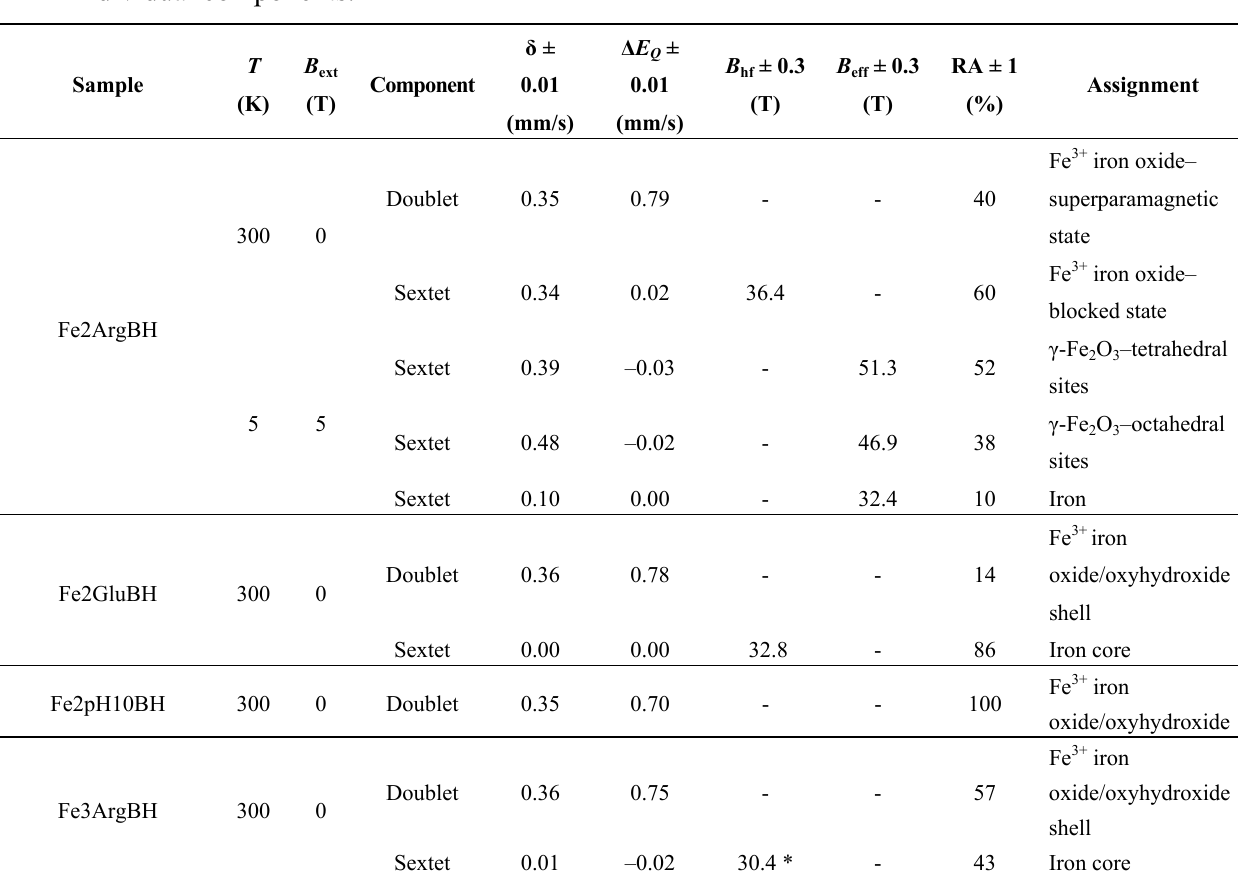
Table 1. Values of the Mössbauer hyperfine parameters, derived from the Mössbauer spectra of the Fe2ArgBH, Fe2GluBH, Fe2pH10BH, Fe3ArgBH, Fe3GluBH, Fe2Arg, Fe2Glu, Fe2ArgGluBH_f (for fresh sample), Fe2ArgGluBH_o (for two-years aged sample), Fe2GluArgBH_f (for fresh sample), Fe2GluArgBH_o (for two-years aged sample), Fe3ArgGluBH, and Fe3GluArgBH sample, where T is the temperature of is the induction of external magnetic field, δ is the isomer shift, Δ E is measurement, B ext Q the quadrupole splitting, B is the hyperfine magnetic field, B is the effective hyperfine hf eff and B ), and RA is the relative spectral area of magnetic field ( i.e. , a vector sum of B hf ext individual